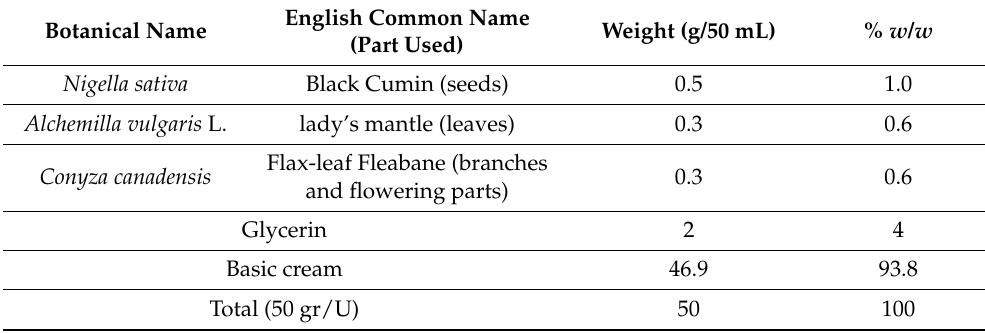
Table 1. Plant extracts used in the preparation of the anti-hemorrhoidal polyherbal cream